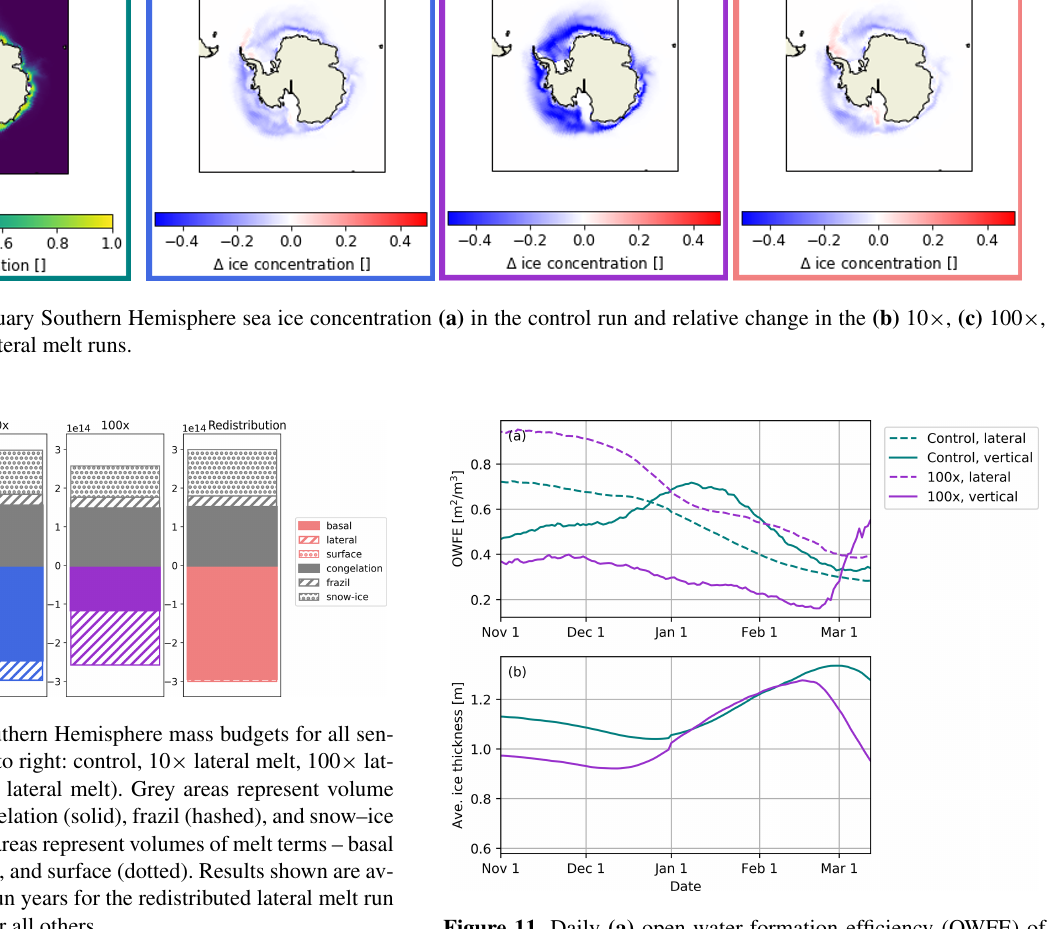
lateral and vertical melt and (b) basin-averaged sea ice thickness in the Southern Hemisphere over the melt season. Results are shown for control and 100 × lateral melt runs only (teal and purple, respec- tively) and are averages over the last 25 run